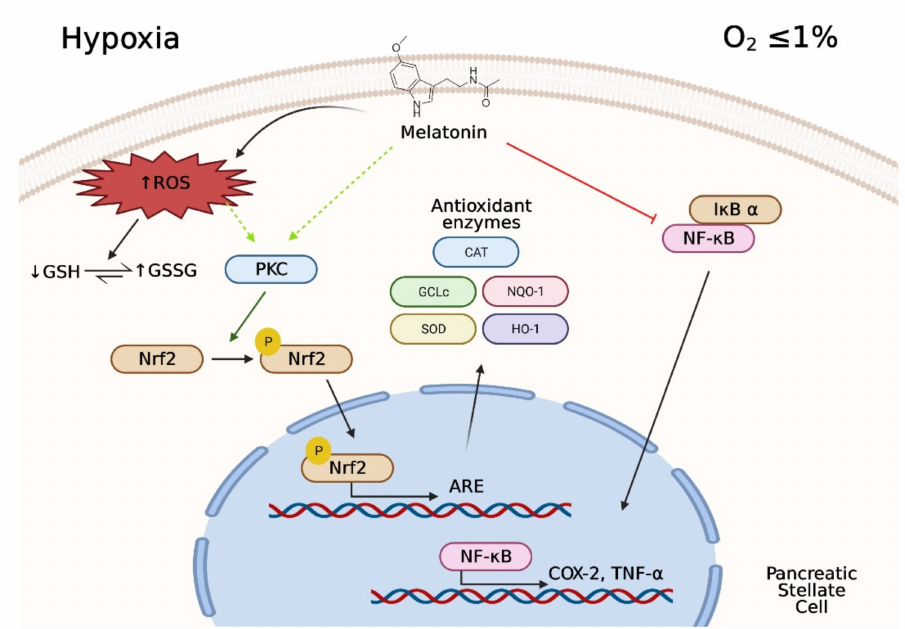
Figure 9. Summary of the major actions of melatonin to modulate PSC responses to hypoxia. The hostile pro-oxidative environment created by hypoxia is modulated by melatonin that, by terms of modulating the antioxidant response element, will lead to diminished oxidative stress. The actions of melatonin also are directed to diminish the inflammatory response settled under hypoxia. These conditions could account for an antifibrotic action of melatonin. Figure created with BioRender software (BioRender.com accessed on 1 February